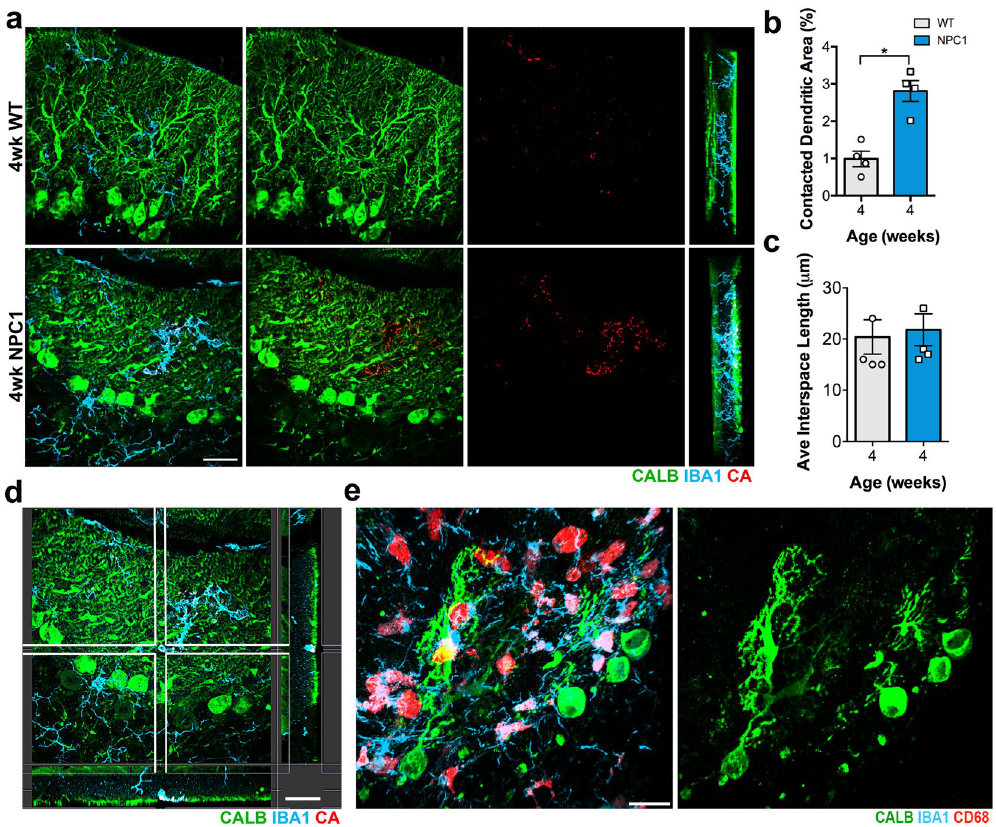
Figure 6. Microglial contacts and interactions with PC dendrites are increased at early stage of NPC disease in Npc1 nmf164 mice. ( a ) Using the Imaris software, the regions of the CALB + dendrites (green) contacted or wrapped by microglia (cyan) were segregated and pseudo-colored in red and named contacted area (CA). The CA was evidently increased in 4 weeks old Npc1 nmf164 PC dendrites when compared to WT. ( b ) Quantitative analysis of the percentage of the PC dendritic area contacted by microglia at 4 weeks of age showed a significant increase in Npc1 nmf164 mice when compared to WT mice. ( c ) No changes in average length of the space between single PC layers were found between WT and Npc1 nmf164 mice. ( d ) Confocal 3D reconstruction of the 4 weeks old Npc1 nmf164 sample presented in ( a ), showing the interaction of a microglia process with PC dendrites. Scale bar: 20 μ m. ( e ) Images showing CALB + PC with degenerating dendrites and activated microglia (IBA1 + /CD68 + ) invading and engulfing them in a 12 weeks old Npc1 nmf164 mouse. All data are presented as mean ± SEM, n = 4 per group, * P < 0.05. Scale bars: 20 μ